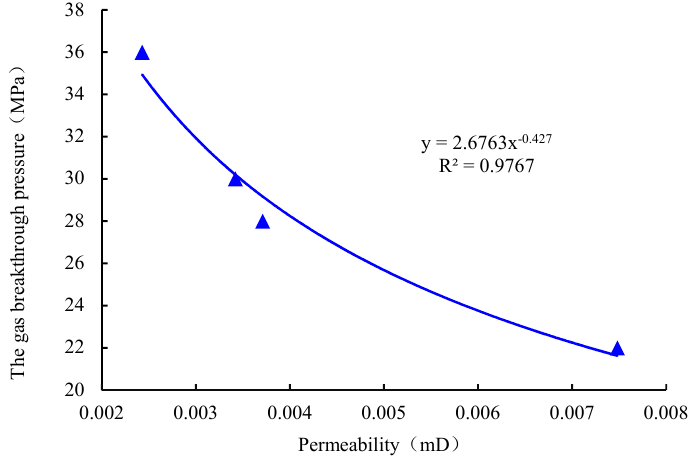
Figure 2. Relationship between permeability and breakthrough pressure.